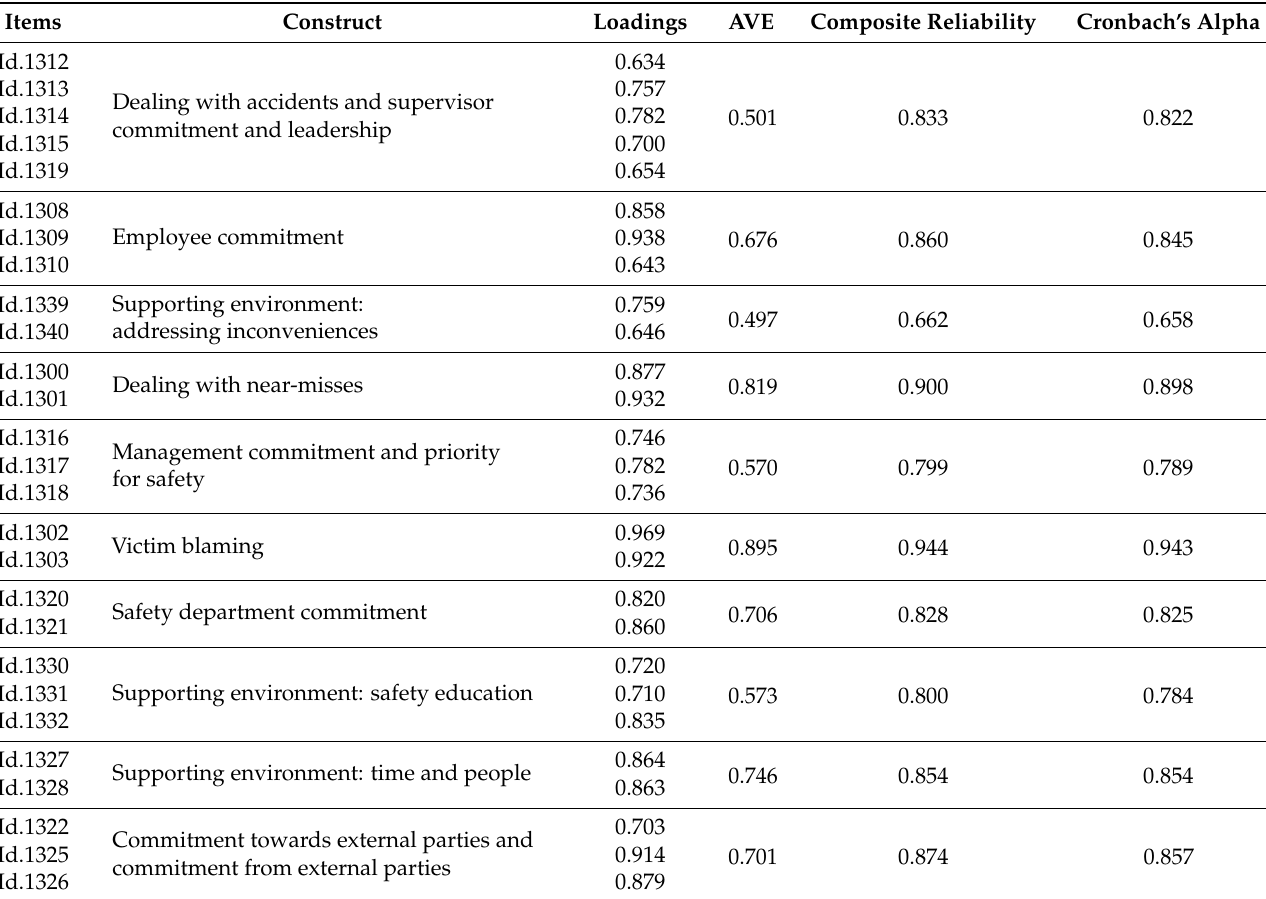
Table 4. Results CFA—Perceptual domain (n = 444)—Assessment of Convergent Validity and